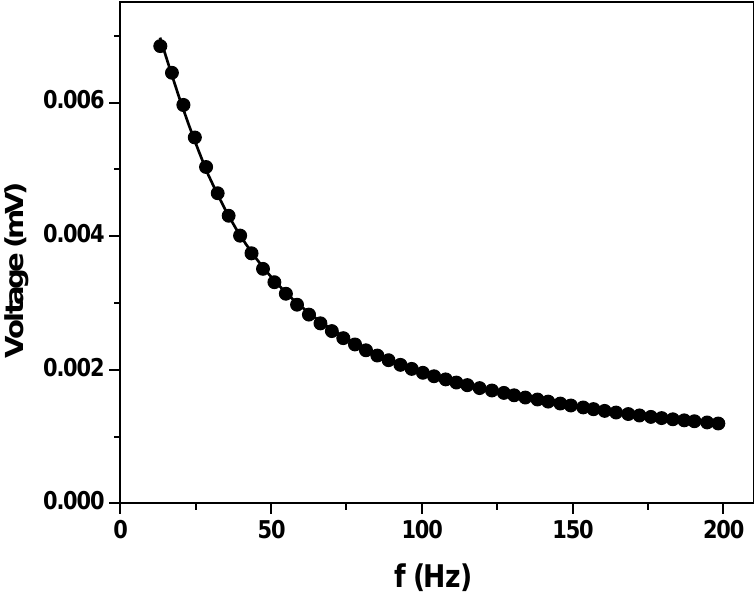
Figure 3. Microphone voltage in function of the frequency of light pulses. The continuous line is the result of the fit of the experimental points to the equation (2). The fit was made using the Origin